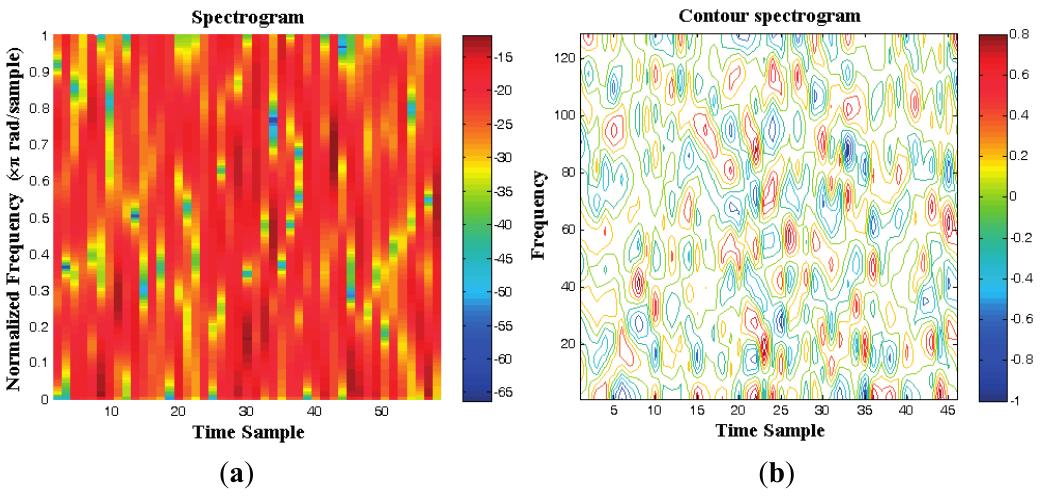
Figure 17. Spectrogram of the acoustical random vibration inside the fairing of the Ariane launch vehicle; hamming window: 16. ( a ) Spectrogram; ( b ) contour of the